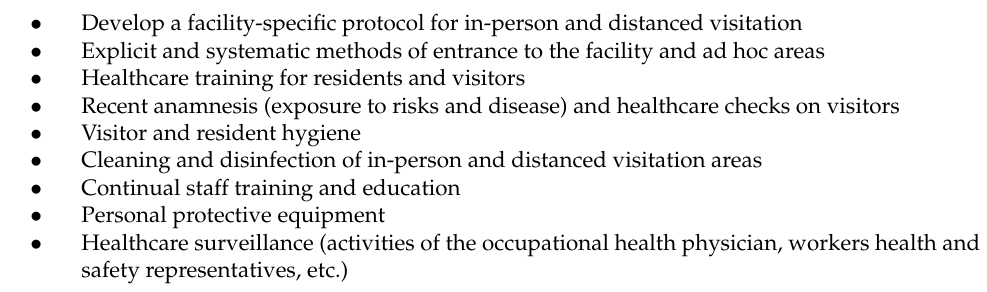
Table 2. Infection prevention measures and managing visitation in residential care